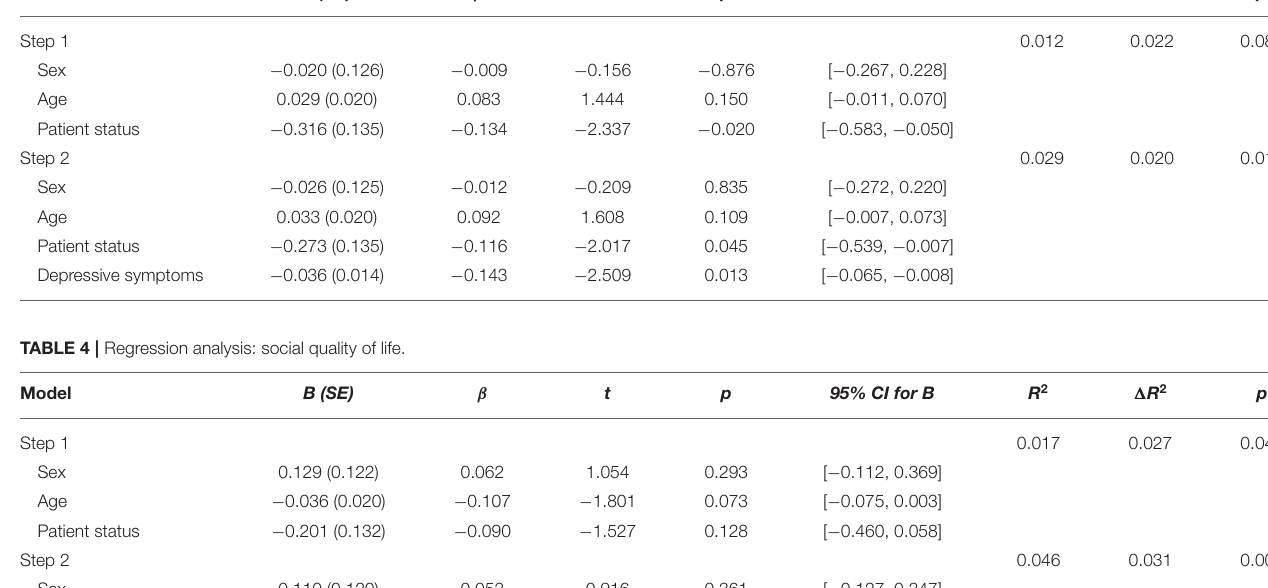
TABLE 3 | Regression analysis: basic needs quality of life. Model